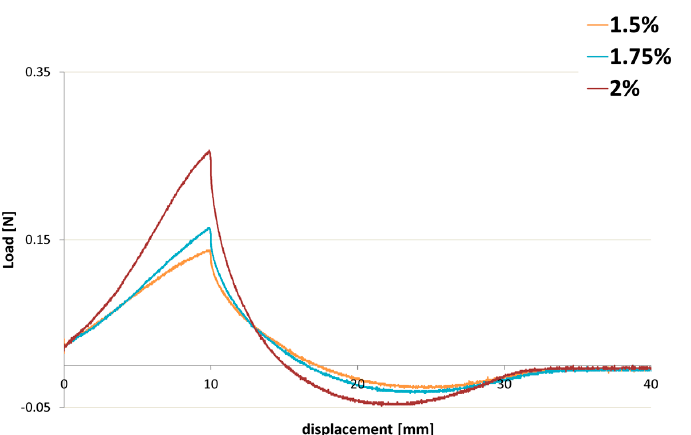
Figure 13. Texture curves obtained by an immersion/de-immersion test performed on the samples prepared with increas- ing polysaccharide total amounts (0.75%, 1%, and 1.5% w/w) at different G–C ratios: 1:2 ( a ) and 1:3 ( b ).